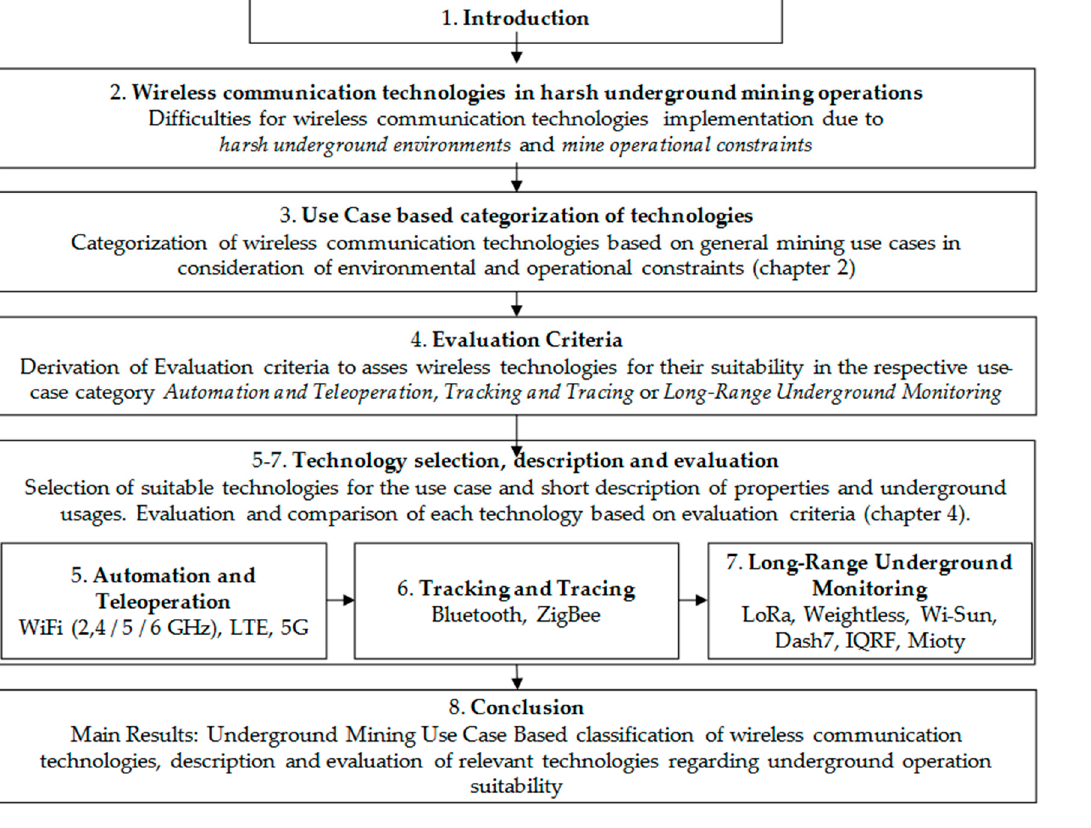
Figure 1. Structure of this paper.